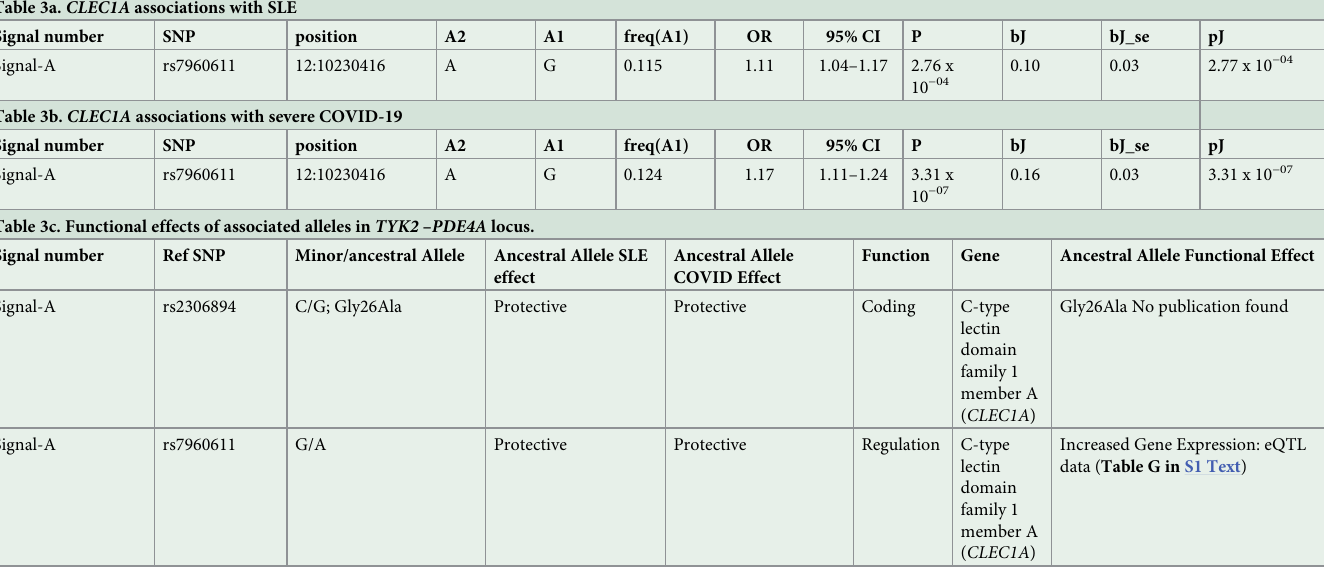
Table 3. CLEC1A association results for a) SLE and b) severe COVID-19 data, and c) summary of functional effects of associated alleles. Independently associated SNPs in SLE and severe COVID-19 are displayed. Table 3a. CLEC1A associations with SLE